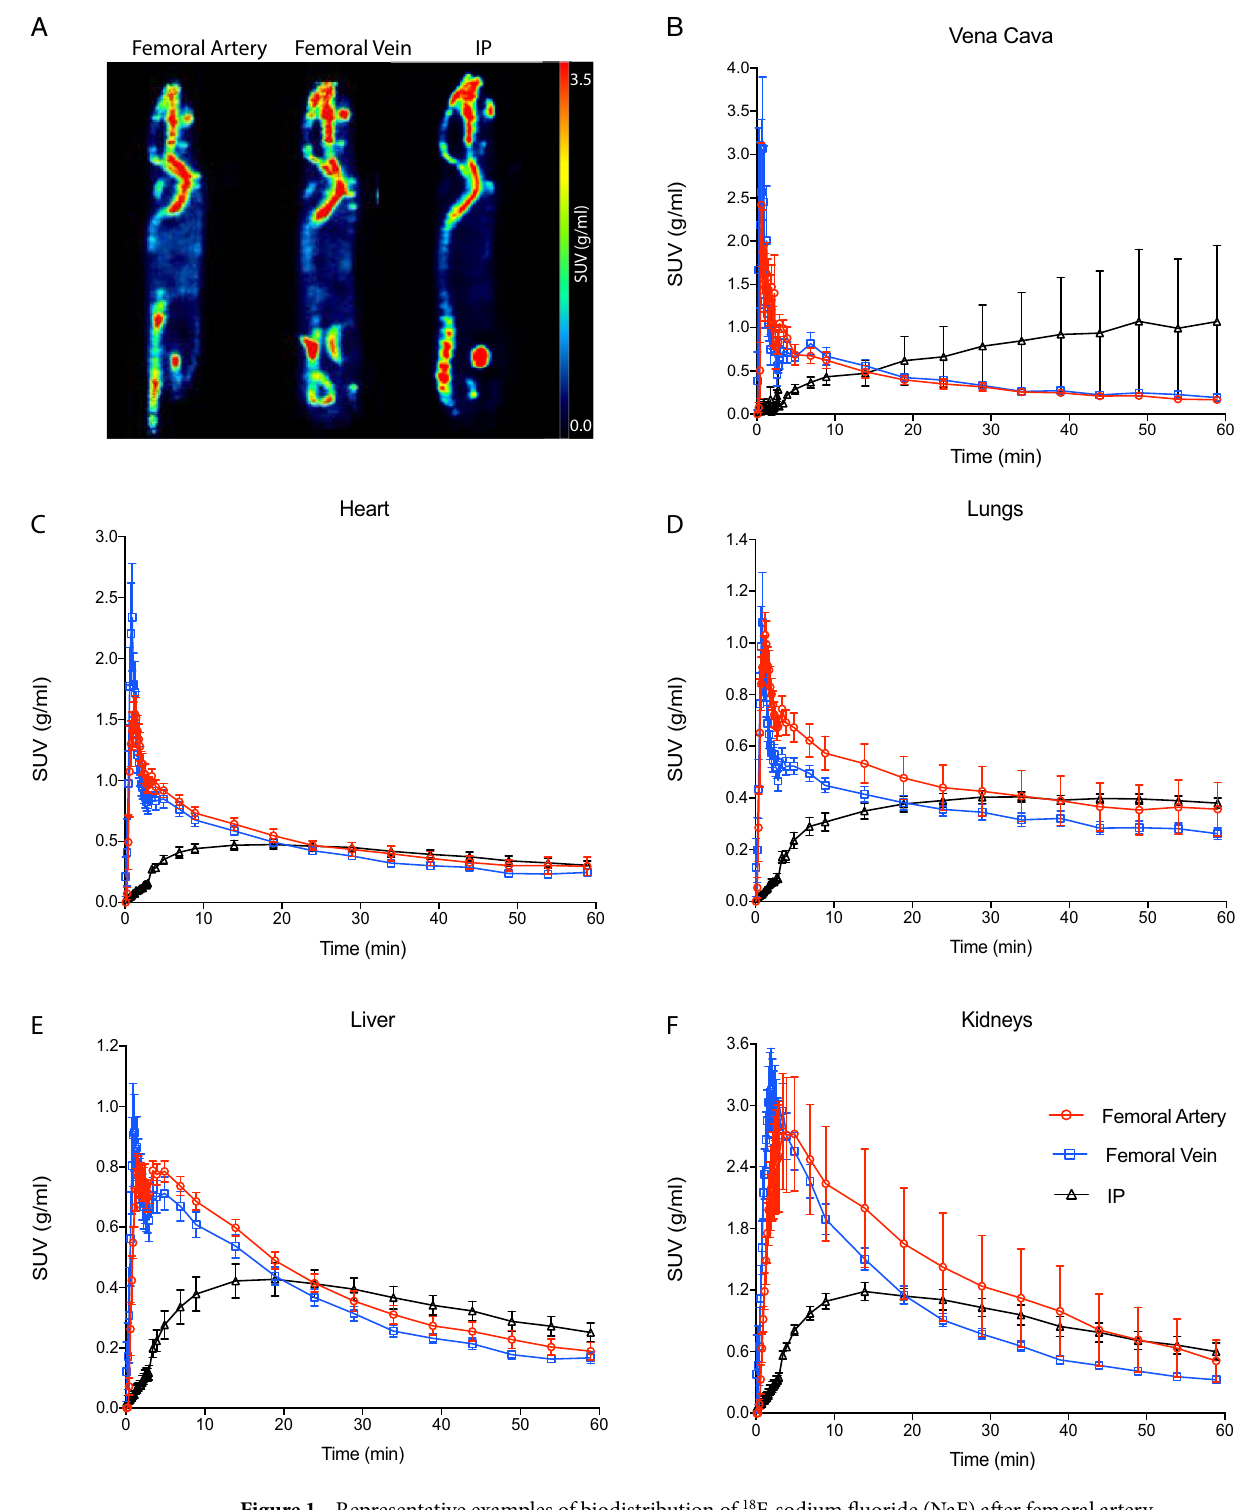
Figure 1. Representative examples of biodistribution of 18 F-sodium fluoride (NaF) after femoral artery, femoral vein and intra peritoneal injections presented as average sagittal section images between 45 and 60 min post-injection ( A ). Mean time-activity curves of the vena cava ( B ), heart ( C ), lungs ( D ), liver ( E ) and kidneys ( F ) after femoral, artery, femoral vein or intraperitoneal (IP) injection. Error bars represent one SEM. SUV standardised uptake